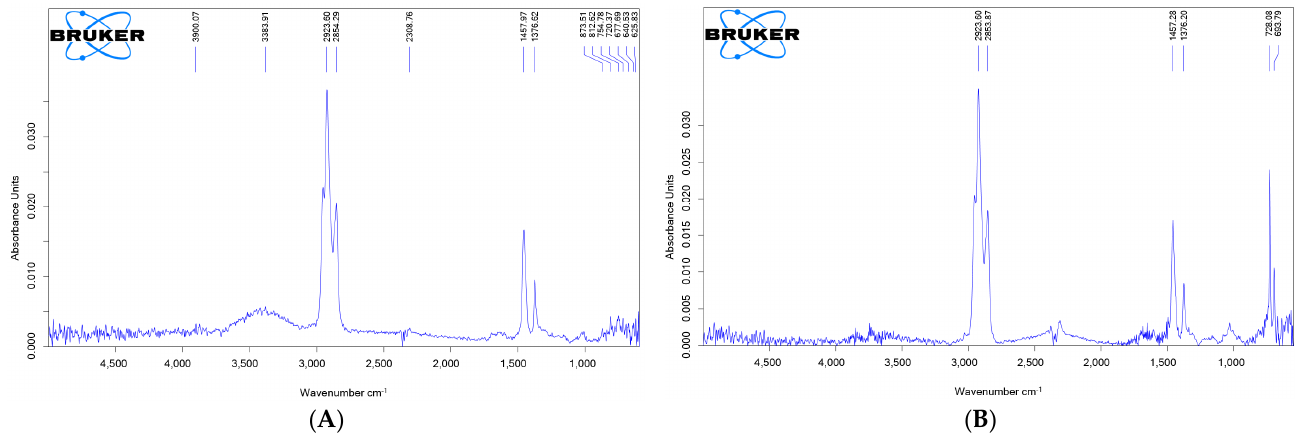
Figure 2. IR spectrum of ARPD solvent ( A ) and spectrum of ARPD + solution + EVA sample ( B ).